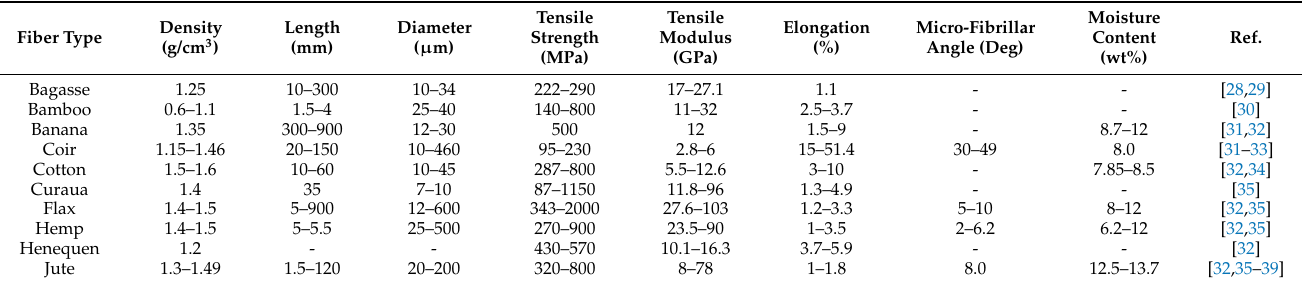
Table 1. Physical and mechanical properties of natural